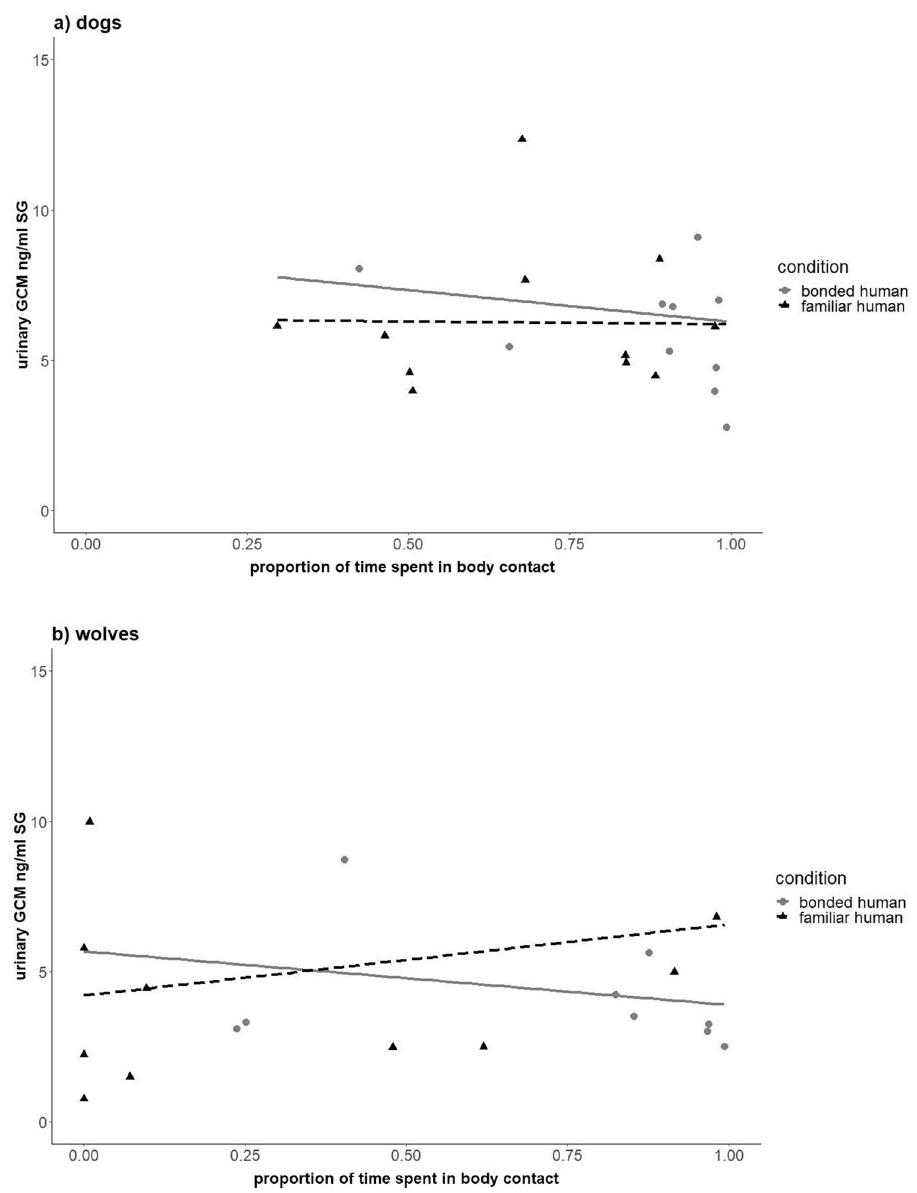
Figure 2. ( A , B ) Glucocorticoids and social contact with humans in pack dogs and wolves. Link between urinary glucocorticoid metabolites (GCM; ng/ml SG) concentrations, proportion of interaction time spent in body contact, and condition (i.e., relationship strength of the interaction partner: bonded = grey dots, solid line; familiar = black triangles; dotted line), in ( A ) pack-living dogs (N = 11; data points shown of all dogs in ‘familiar’ condition; data points shown of 10 dogs in ‘bonded’ condition due to insufficient urine sample volume for GCM measurement), and ( B ) wolves (N = 10; data points shown of all wolves in ‘familiar’ condition; data points shown of 9 wolves in ‘bonded’ condition due to insufficient urine sample volume for GCM